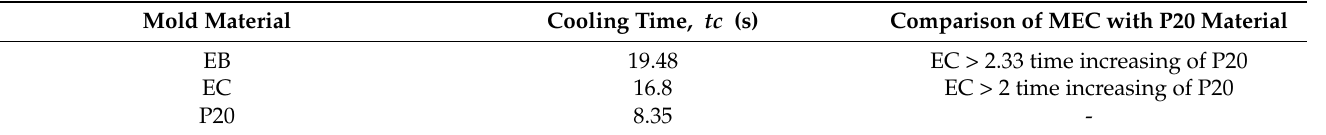
Table 9. Result of cooling